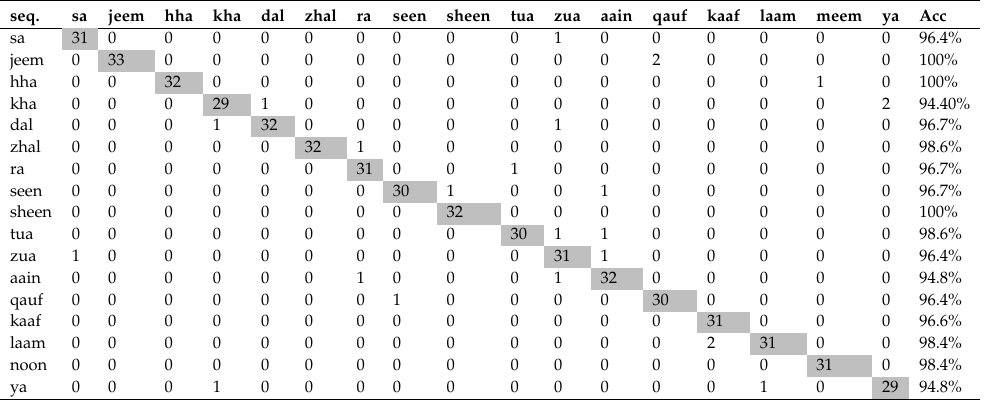
Table 7. AlexNet with data